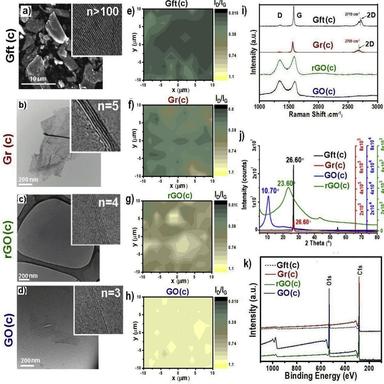
Structural characterization showing typical morphology and number of layers of control samples a) Gft (c) (SEM), b) Gr (c) (TEM), c) rGO (c) (TEM) and d) GO (c) (TEM) particles. HRTEM images are presented as insets showing number of layers. e-h) Raman maps of these materials showing the level of disorder using Raman peak intensity ratio of D and G bands (ID/IG). i) Representative Raman spectra of Gft (c), Gr (c), rGO (c) and GO (c). (j) XRD profiles of Gft (c), Gr (c), rGO (c) and GO (c) powders with their